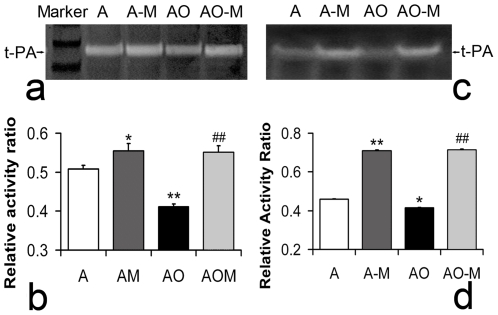
tPA activity of astrocyte lysates and conditional media.Zymography (a, b) shows that MSCs significantly increased tPA activity in normal cultured astrocytes and in OGD treated astrocytes (c), and similar results were obtained using the conditioned media harvested from the concomitant groups (d). Marker: prestained protein marker; A: normal cultured astrocytes; A-M: normal astrocytes co-cultured with MSCs; AO: OGD astrocytes; AO-M: OGD astrocytes co-cultured with MSCs. *P<0.05, **P<0.01, compared with group A; ##P<0.01, compared with group AO.